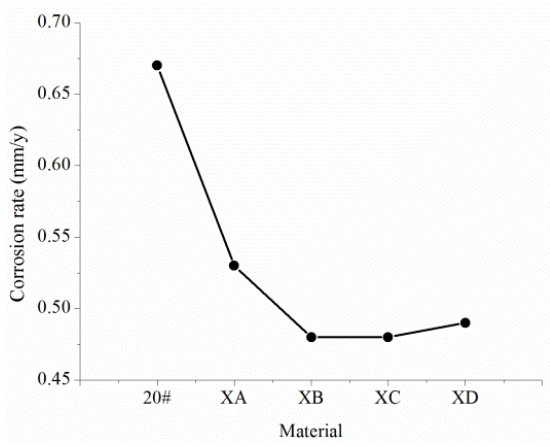
Figure 12. Corrosion rate of different materials.